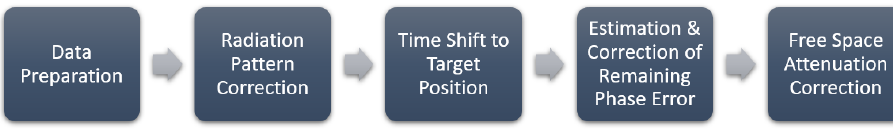
Figure 5. Signal processing steps for a single measurement